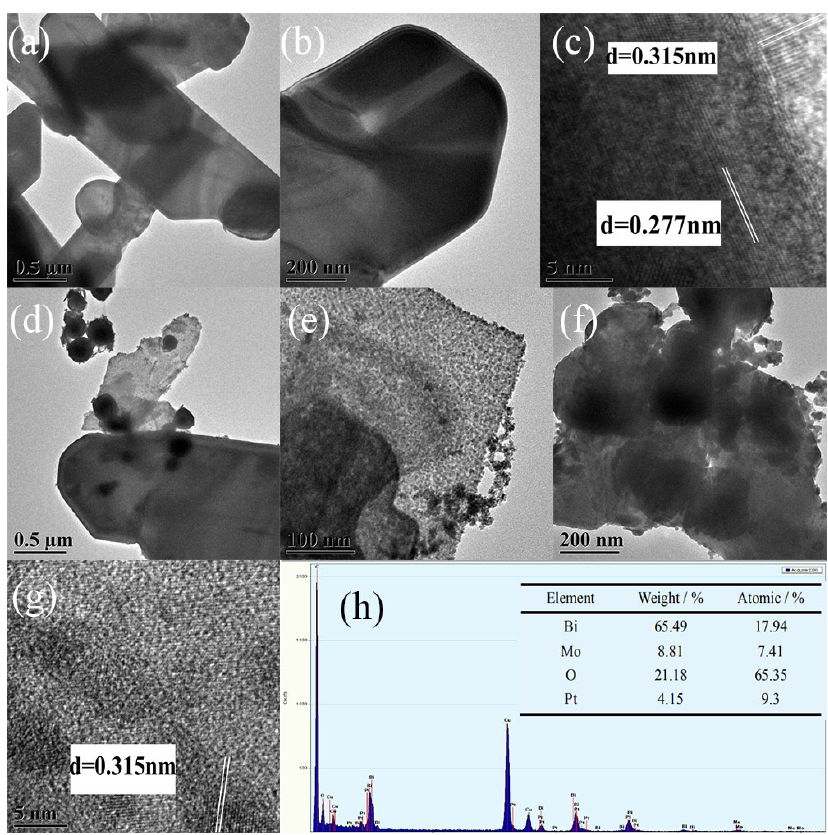
Figure 4. TEM images of the as-prepared samples: ( a – c ) γ -Bi 2 MoO 6 (nitric acid method, pH = 9, 180 ◦ C), ( d – e ) 4 wt % Pt / γ -Bi 2 MoO 6 (nitric acid method, pH = 9, 180 ◦ C), ( f – g ) recycled 4 wt % Pt / γ -Bi 2 MoO 6 (nitric acid method, pH = 9, 180 ◦ C), and ( h ) the corresponding EDX spectra of 4 wt % Pt / γ -Bi 2 MoO 6 (nitric acid method, pH = 9, 180 ◦ C).